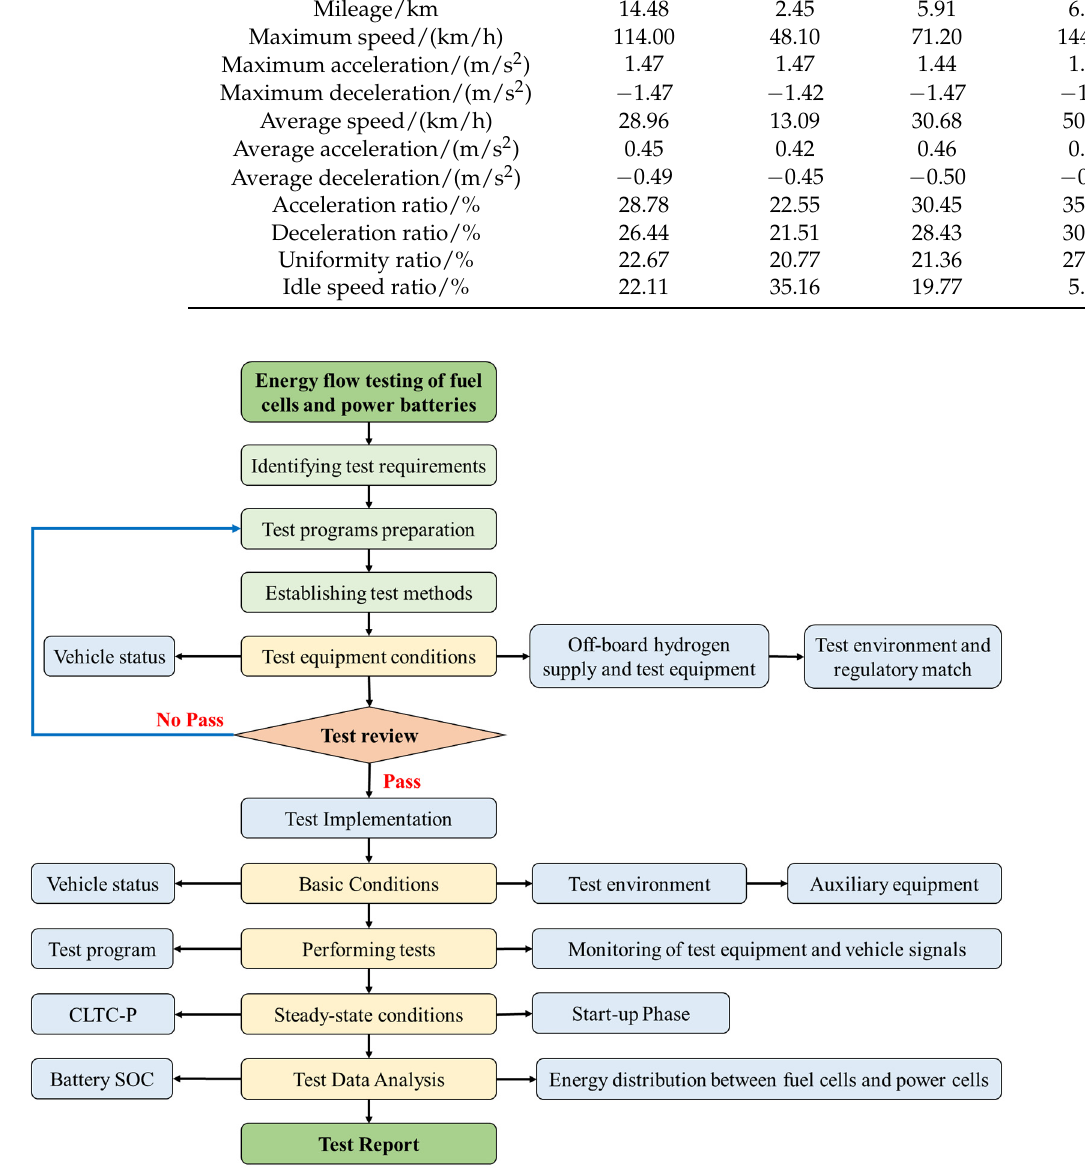
Figure 4. CLTC-P working condition curve.